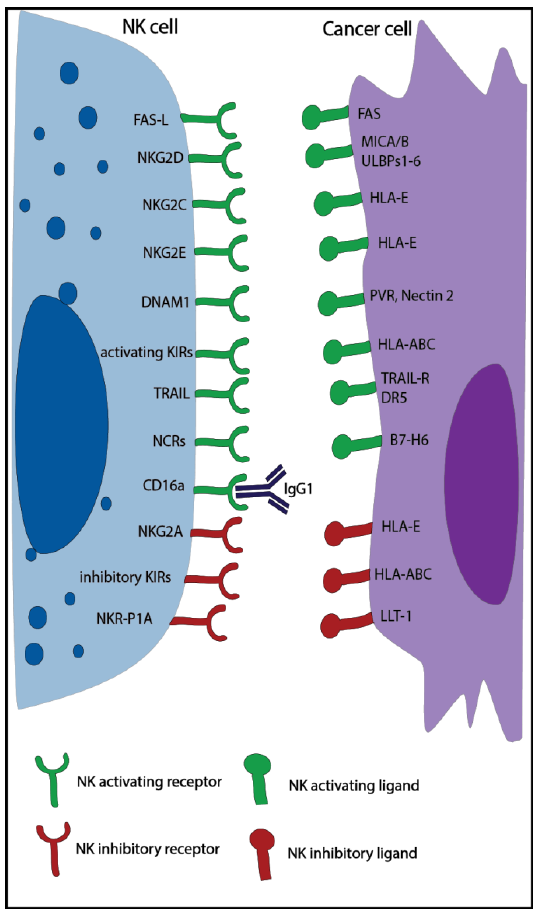
Figure 1. Overview of major natural killer (NK) cell activating and inhibitory receptors and their corresponding ligands expressed on tumor cells. KIR: killer cell immunoglobulin-like receptors; NKG: natural killer receptor; TRAIL: tumor necrosis factor-related apoptosis-inducing ligand; NCR: natural cytotoxicity receptors; HLA: human leukocyte antigen; MICA: MHC class I polypeptide–related sequence; PVR: poliovirus receptor; DR5: death receptor 5; DNAM1: DNAX Accessory Molecule-1, ULBP1-6: UL16 binding protein 1-6, LLT-1: lectin-like